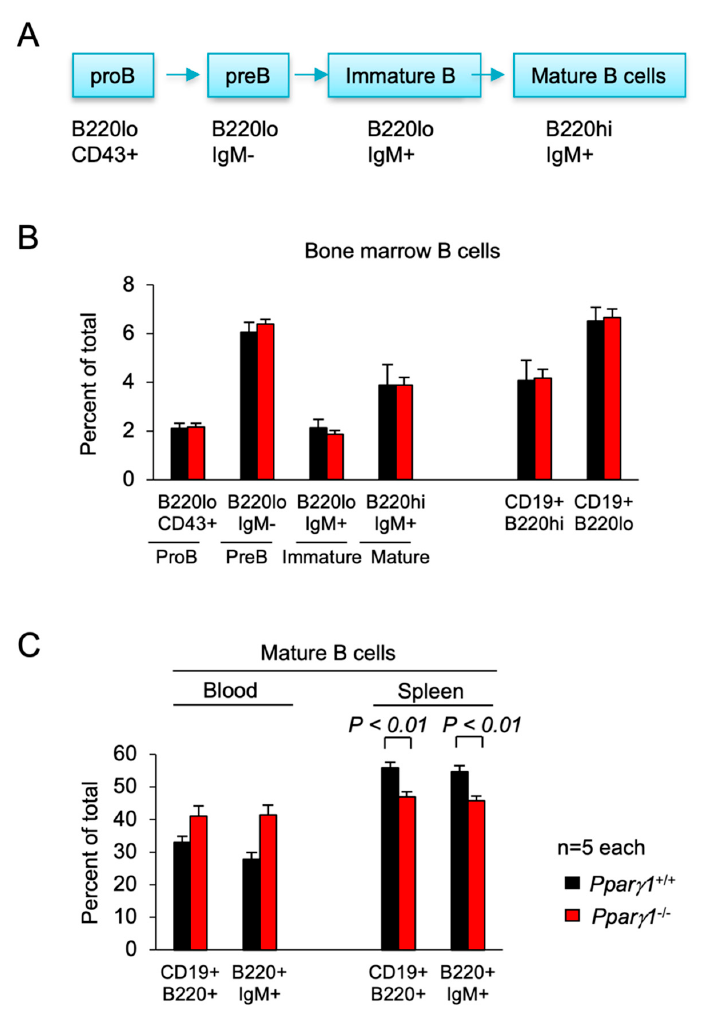
Figure 4. B cell differentiation in Ppar γ 1 +/+ vs. Ppar γ 1 − / − multigenic mice. ( A ). Schematic representation of lineage differentiation from pro B cells to mature B cells. ( B ). Lineage indices of Ppar γ 1 +/+ vs. Ppar γ 1 − / − multigenic mice ( Ppar γ 1 wt/wt , vs. Ppar γ 1 fl/fl , both in ROSA26 CreERT2 , Rosa26 mTmG and MMTV-ErbB2 background and treated with tamoxifen) with relative distribution of B cell lineage components in the bone marrow (BM). Relative proportion of Pro-B, Pre-B, Immature B cells, and Mature B cells (B220 high IgM + ) are shown. ( C ). The proportion of Mature B cells are shown for the blood and spleen. Data are represented as mean ± SEM. n = 10 total.